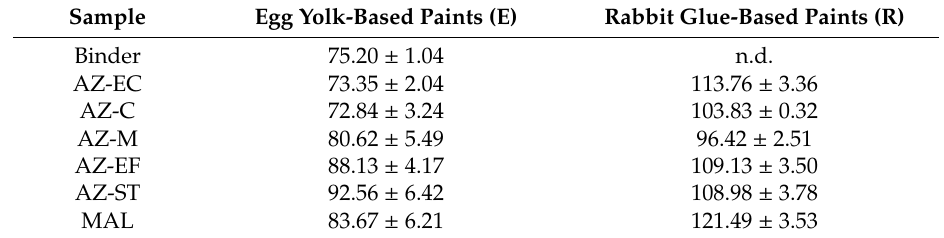
Table 4. Static contact angle (SCA) of reference paint mock-ups. See Table 1 for paint sample labeling. Sample Egg Yolk-Based Paints (E) Rabbit Glue-Based Paints